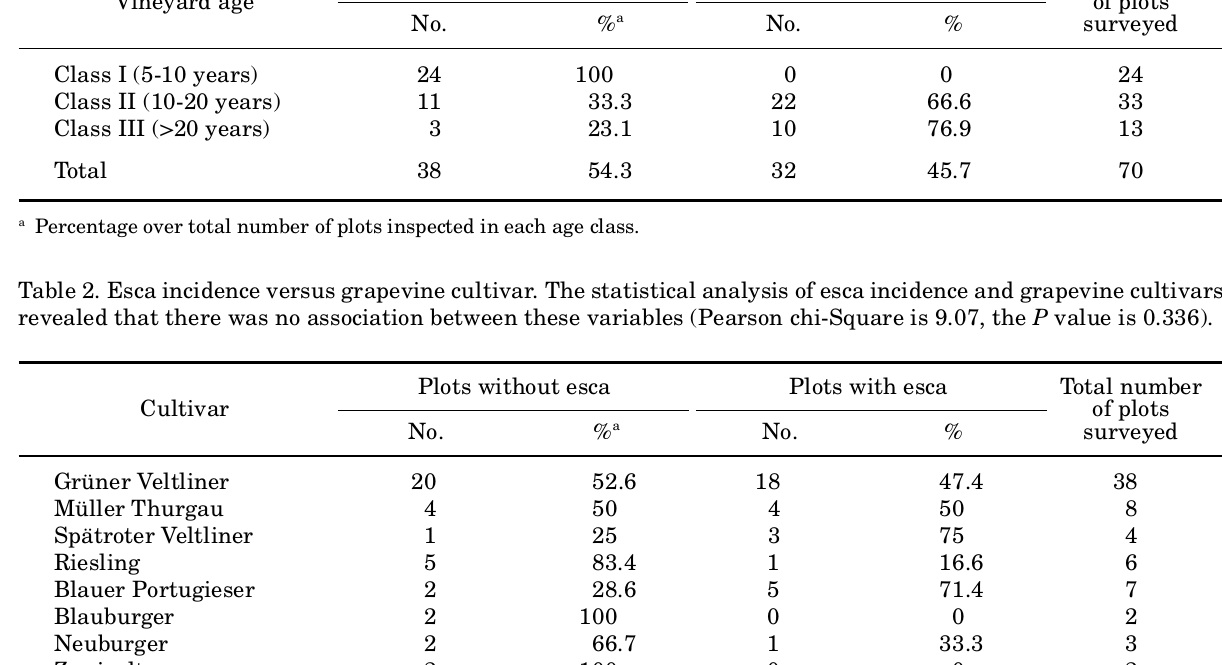
Table 1. Esca incidence versus vineyard age. The relationship between incidence of esca and vineyard age was demonstrated by the Pearson chi-Square Test. The resulting chi-Square is 31.15, the P value < 0.0005. Plots without esca Plots with esca Total number Vineyard age of plots No. % a No. % surveyed